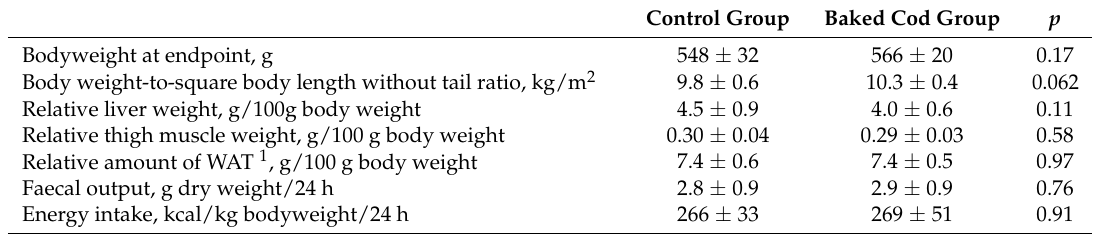
Table 3. Bodyweight at endpoint, body weight-to-square body length, relative organ weight, faecal output and energy